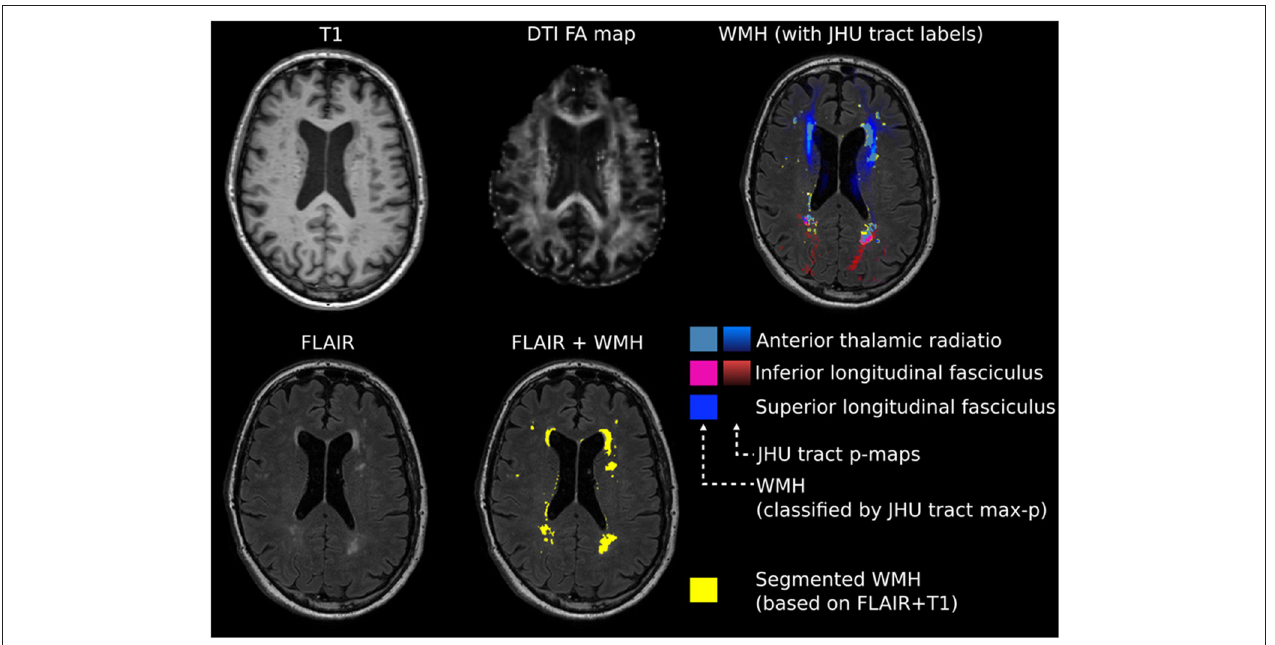
FIGURE 1 | Exemplary image processing of a single patient for region of interest (ROI)-based white matter hyperintensity (WMH) assessment. Intensity threshold for WMHs was automatically determined by choosing the first upper quantile of the gray matter as a threshold. Individual fractional anisotropy (FA) maps were coregistered with the Johns Hopkins University (JHU) atlas FA maps. Whole-brain and tract-specific WMH volumes were automatically calculated in mm 3